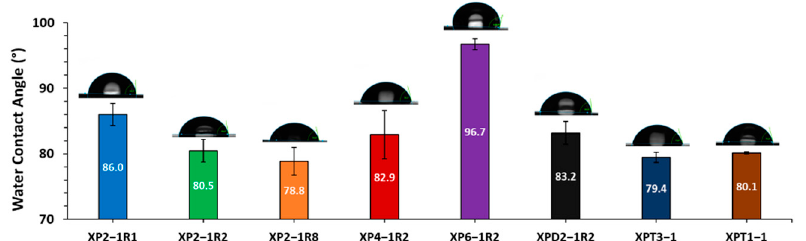
Figure 7. Xerogel materials with the average water contact angles, standard deviations and represen- tative pictures.